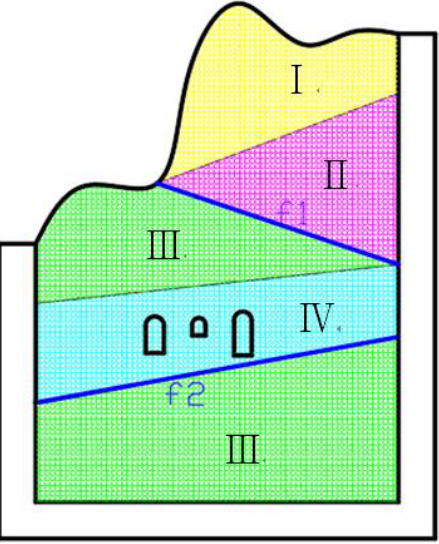
Figure 3. Classification of SR of underground cavern group. Table 1. Physical and mechanical parameters of various surrounding rocks.